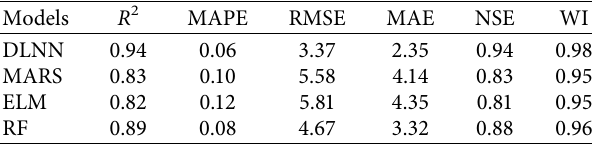
Table 4: The statistical measurements for the developed model AI model over the training phase for 80-20% data division scenario.